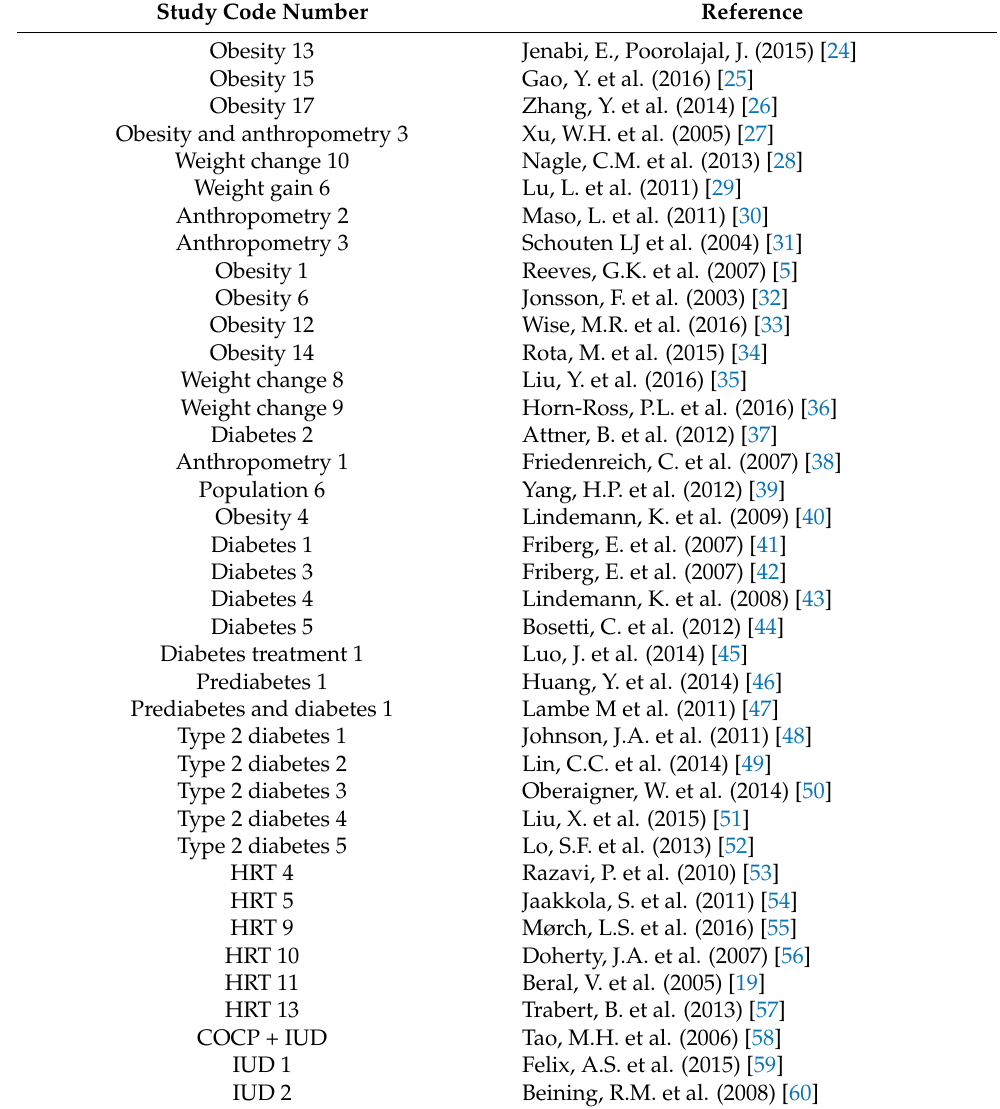
Table 1. Studies used in the meta-analysis of risk